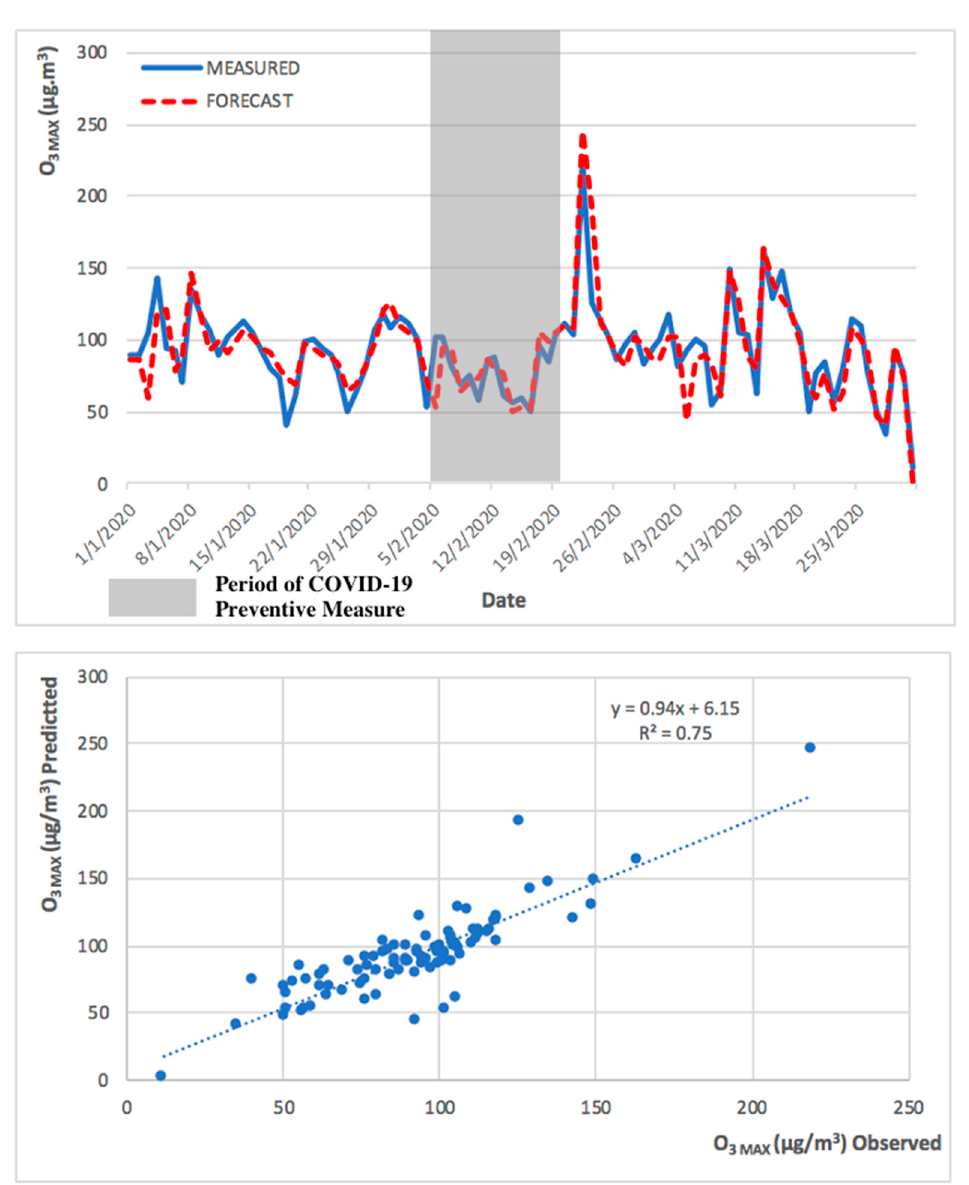
Figure 10. Observed and predicted O 3 MAX concentrations for Taipa Ambient during preventive measures of COVID-19 pandemic (from January to March 2020).